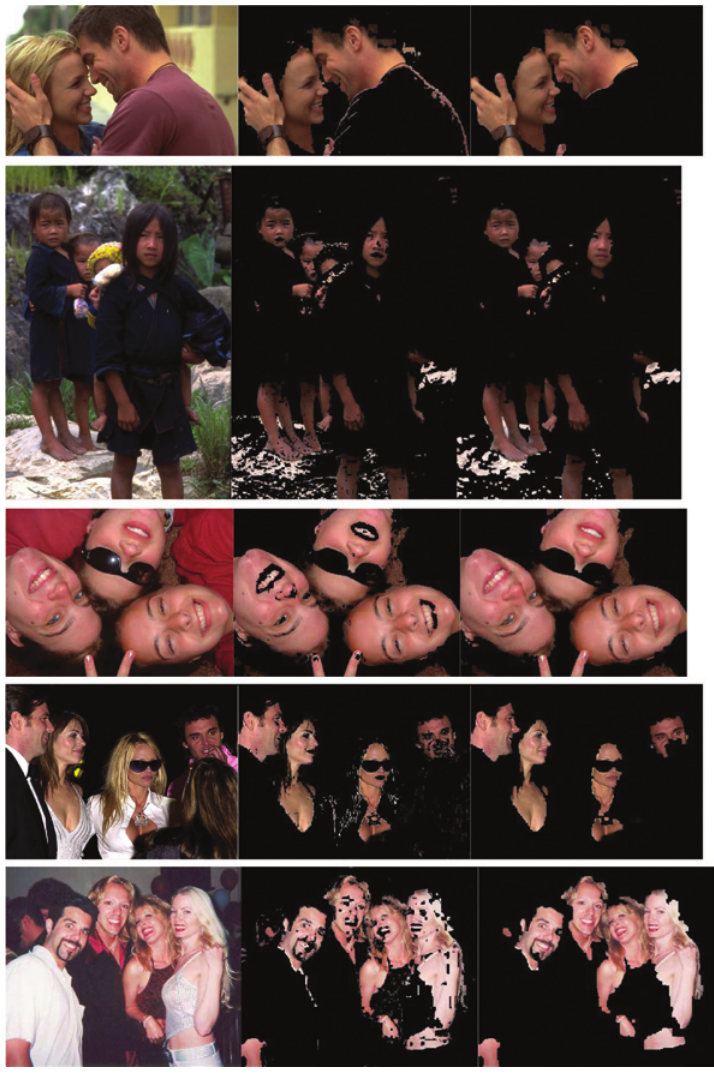
Figure 5. Experimental Results on the UCD